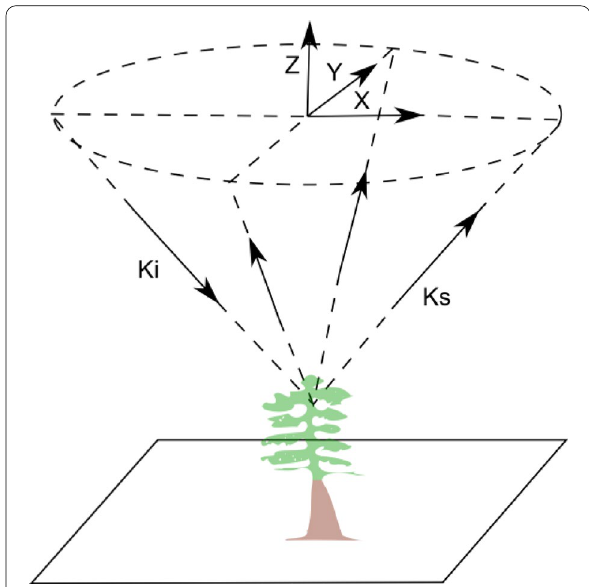
Fig. 3 The geometry of the specular cone. While the incidence angle is given by Ki, the scattering azimuth angles given by Ks range from 0° to 360°, thus forming a specular